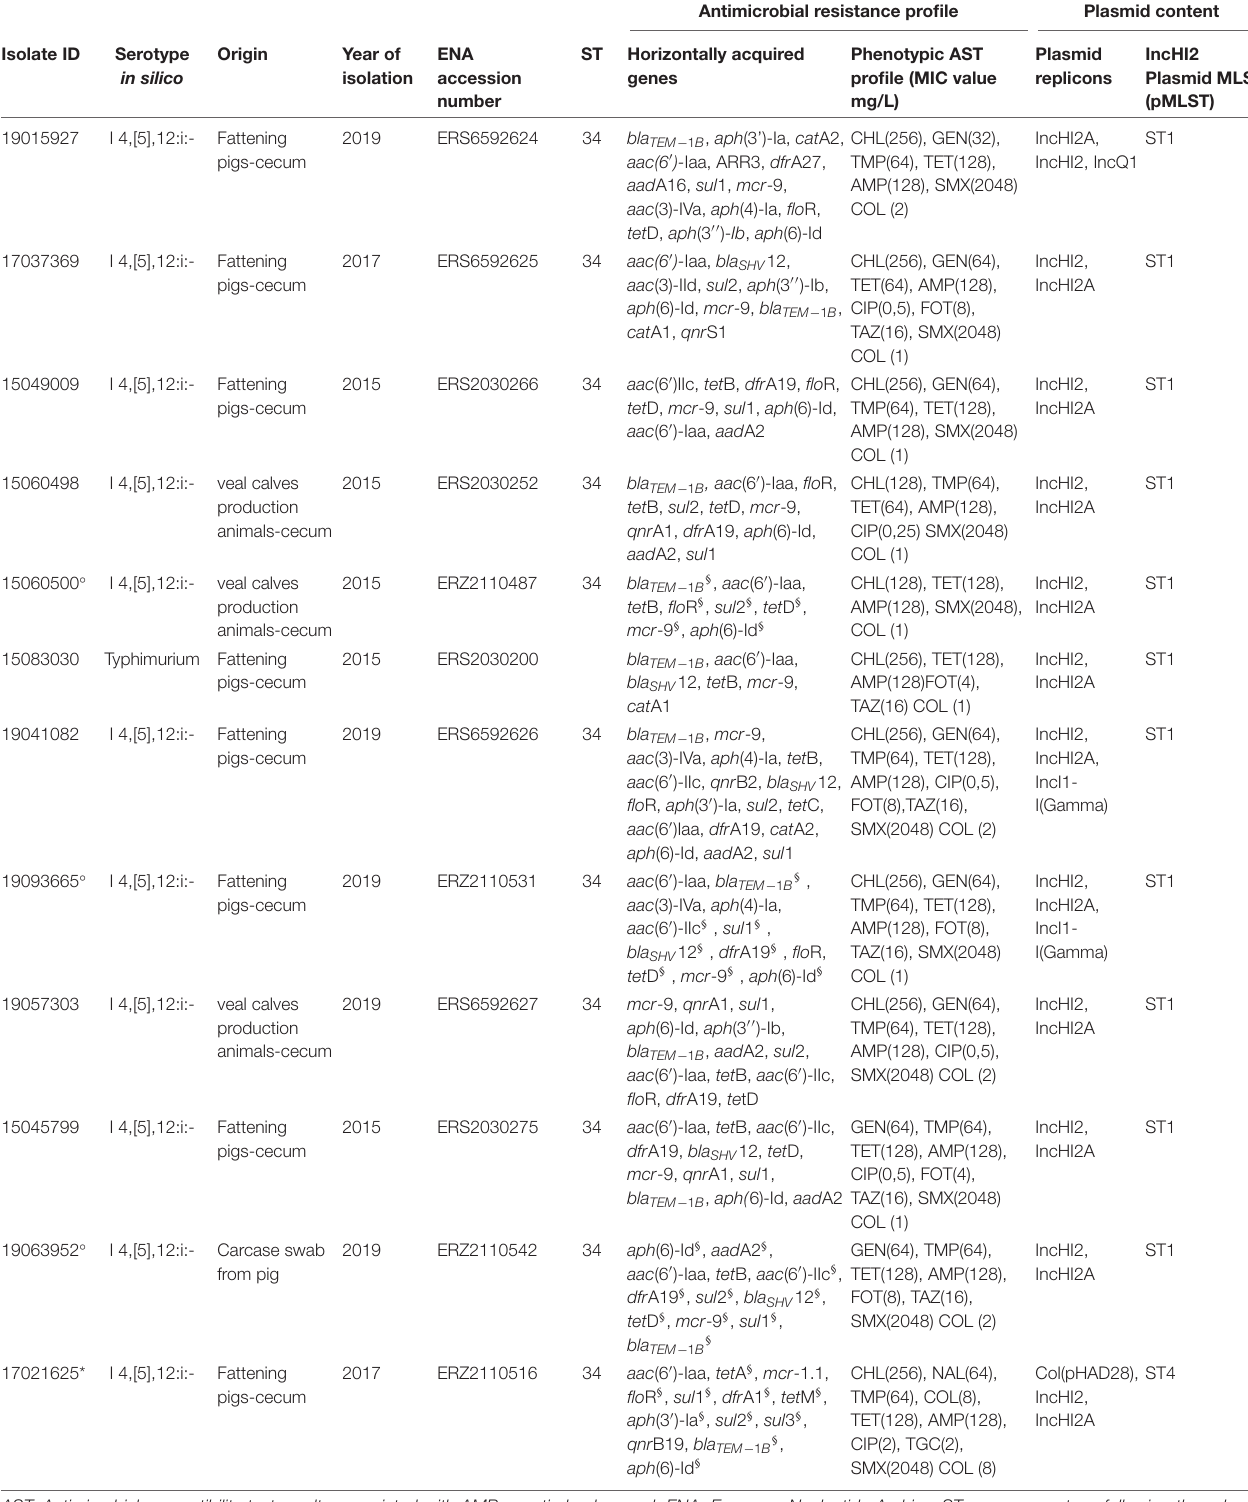
TABLE 1 | Genotypic and phenotypic characterization of the mcr- 9 and selected mcr- 1 carrying isolates analyzed by WGS. Antimicrobial resistance profile Plasmid